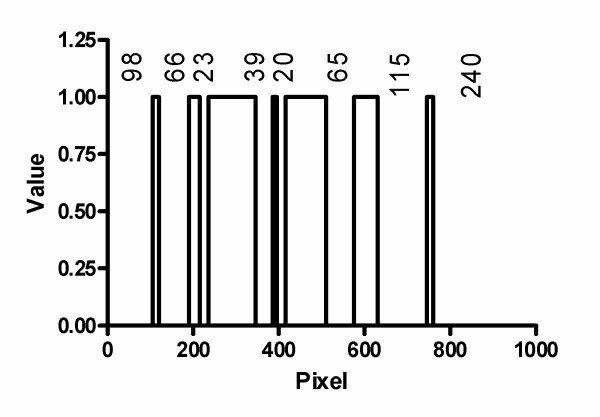
Runs along a horizontal scanline at the top of the segmented image in Figure 1 (right). The numbers above the black runs indicate the length of the individual runs.